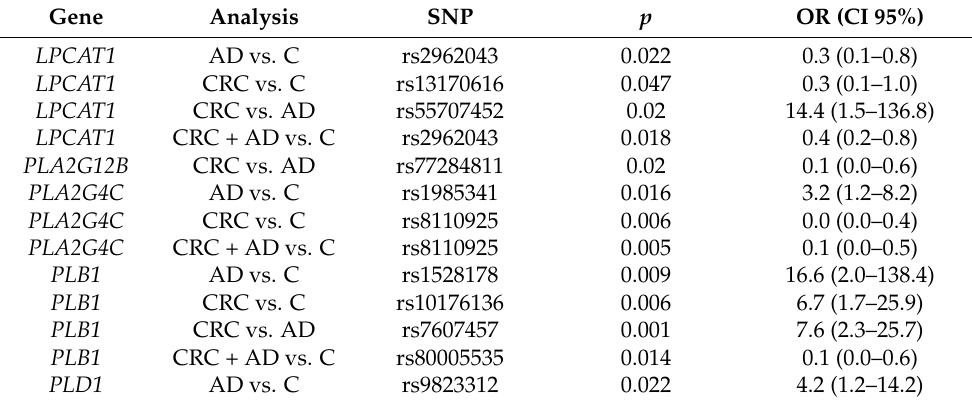
Table 2. Association study results of significant SNPs in genes of “Glycerophospholipid, Sphingolipid metabolism, Glycosylphosphatidylinositol(GPI)-anchor biosynthesis pathway”. AD vs. C, adenoma vs. healthy controls; CRC vs. C, colorectal cancer vs. healthy controls; CRC vs. AD, colorectal cancer vs. adenoma; CRC + AD vs. C, adenomas and colorectal cancer vs. controls. OR, odds-ratio; CI 95%, 95% of confidence interval of